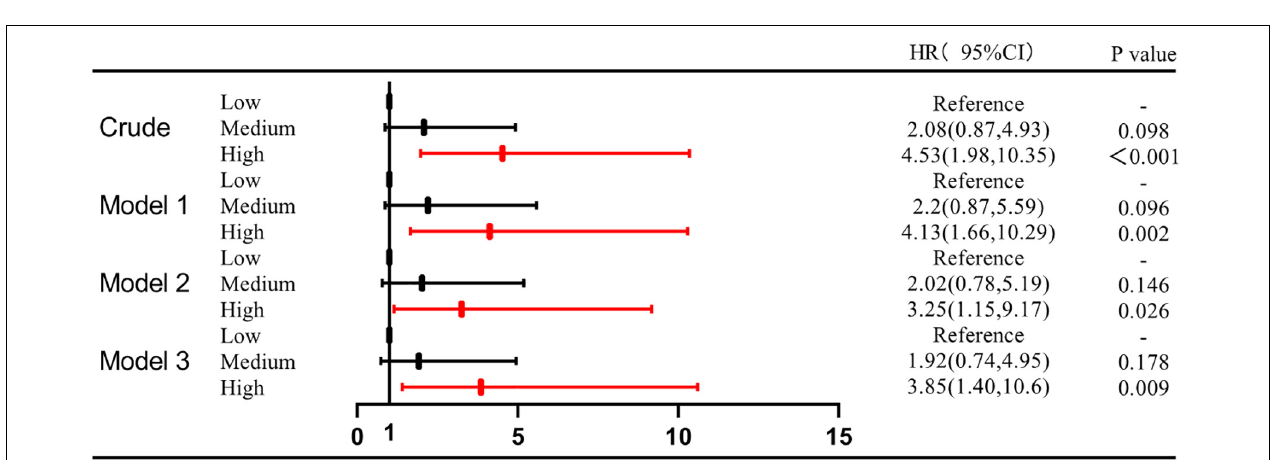
FIGURE 2 | (A) Comparison of plasma MPO levels among groups based on GRACE score. (B) Correlation between GRACE score and plasma MPO levels. (C) Comparison of plasma MPO levels among groups based on MACEs. (D) Kaplan-Meier survival curve of 1-year MACEs in 271 NSTEMI patients. Model 1: adjustment for traditional cardiovascular risk factors (age, sex, current/former smoking, hypertension, hyperlipidemia, diabetes, previous stroke, and previous MI and family history of CHD). Model 2: Model 1 + Inflammation Marker (hs-CRP; leukocyte count; neutrophil count; fibrinogen). Model 3: Model 2 + GRACE score.